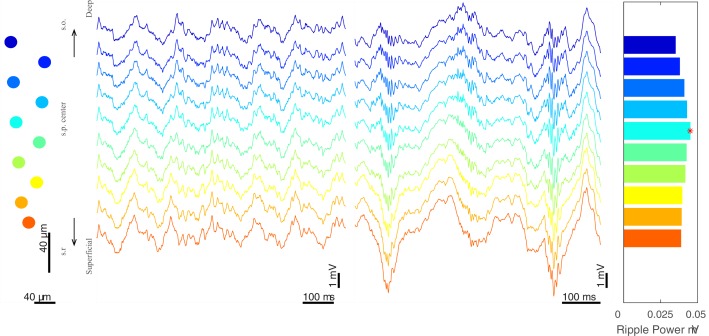
LFP recordings at different recording depths.Example of recording sites on a Buzsaki probe (far left), traces showing theta oscillations (center left) and ripples (center right), and mean ripple power across channels with the channel with the maximum ripple power marked with a red star (far right). The channel with the maximum ripple power was used to identify the center of pyramidal layer in hippocampal CA1. Recording channels spanned 160–200 µm and most channels were in the pyramidal layer or immediately above or below it. s.o., stratum oriens; s.p. stratum pyramidal; s.r., stratum radiatum.